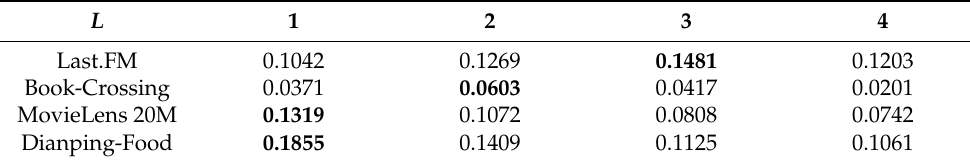
Table 3. The Recall@10 results in terms of the maximum hop number L .